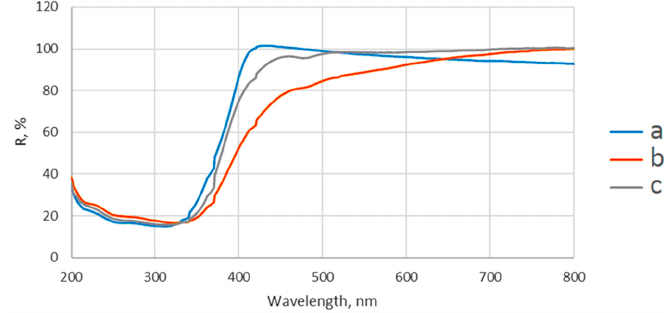
Figure 5. UV-VIS diffuse reflectance spectra of P25 ( a ); TiO 2 -1% Fe–N, pH ~5.5 ( b ); and TiO 2 -1% Fe–N, pH ~8.5 ( c ) samples.